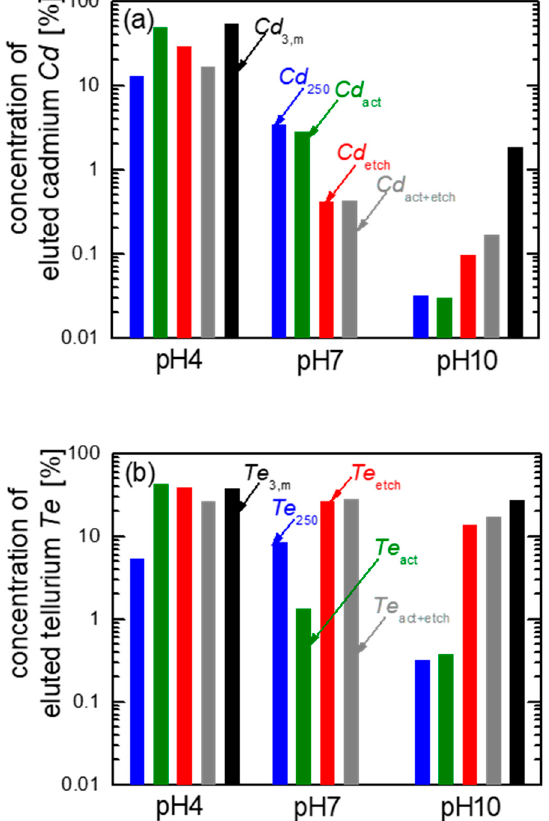
Figure 7. Eluted Cd and Te out of CdTe 250 -powder after t = 83 d in aqueous solutions with pH4, pH7 and pH10. The powder is processed like CdTe in solar cells. Data for Cd 3,m and Te 3,m out of milled CdTe-modules (black data) are only available until t = 56 d in pH4 and pH10 [6]. ( a ) Activation (green data) increases the elution of Cd in pH4. While it holds Cd act > Cd 250 etching to Cd etch (red data) and the combination of activation and etching Cd act+etch (grey data) decreases eluted Cd. Nonetheless, however, the data from the milled modules, Cd 3,m , (black data) are highest. Leaching in pH7 and pH10 shows different absolute values. ( b ) In the case of Te, activation, etching and the combination of both increase the elution of Te 250 in pH4 while in pH7 and pH10 only Te etch and Te act+etch increase to Te 3,m . Activation only decreases the elution of Te in pH7 when compared to the unprocessed powder (blue data), while for pH10, the Te elution is only slightly increased.